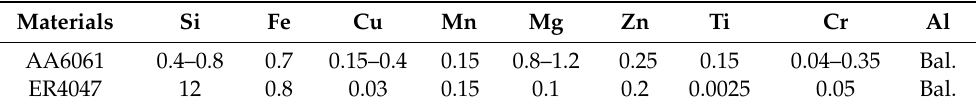
Table 1. Chemical compositions of 6061 aluminum alloy